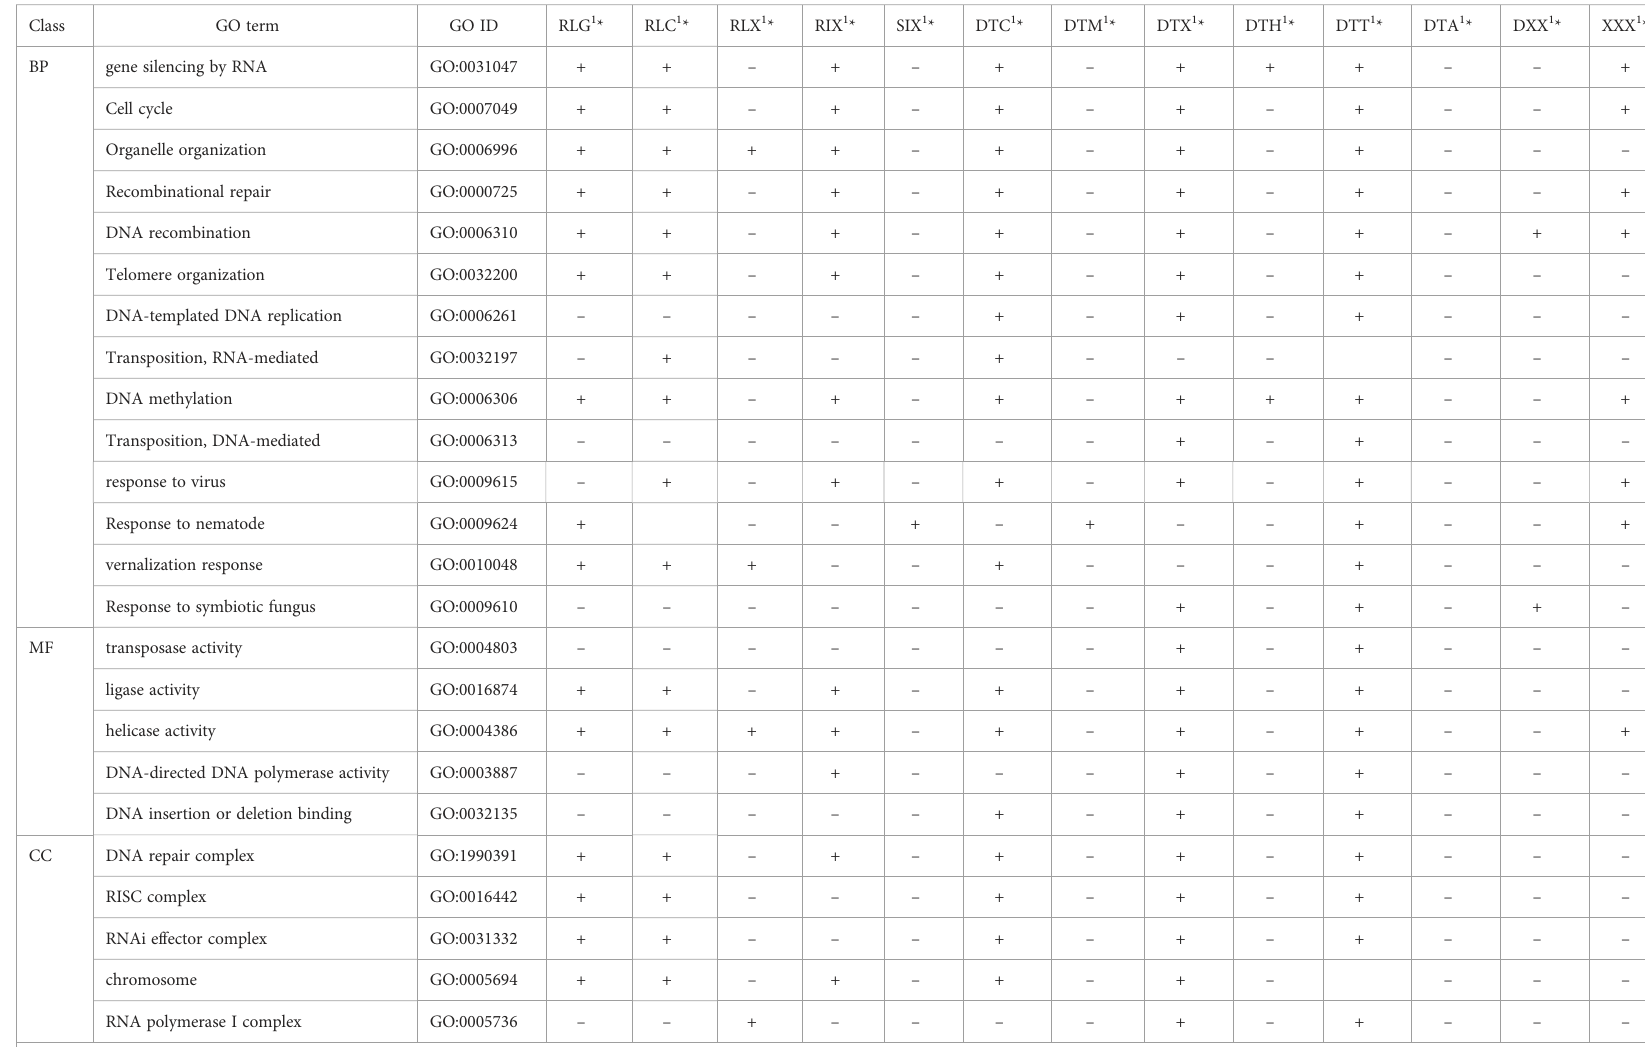
TABLE 5 Signi fi cantly enriched GO terms found in GO SEA preformed for triads which include TE insertions from mentioned superfamily in each of the three GO domains classes: Biological Process (BP), Cellular Component (CC), and Molecular Function (MF). Class